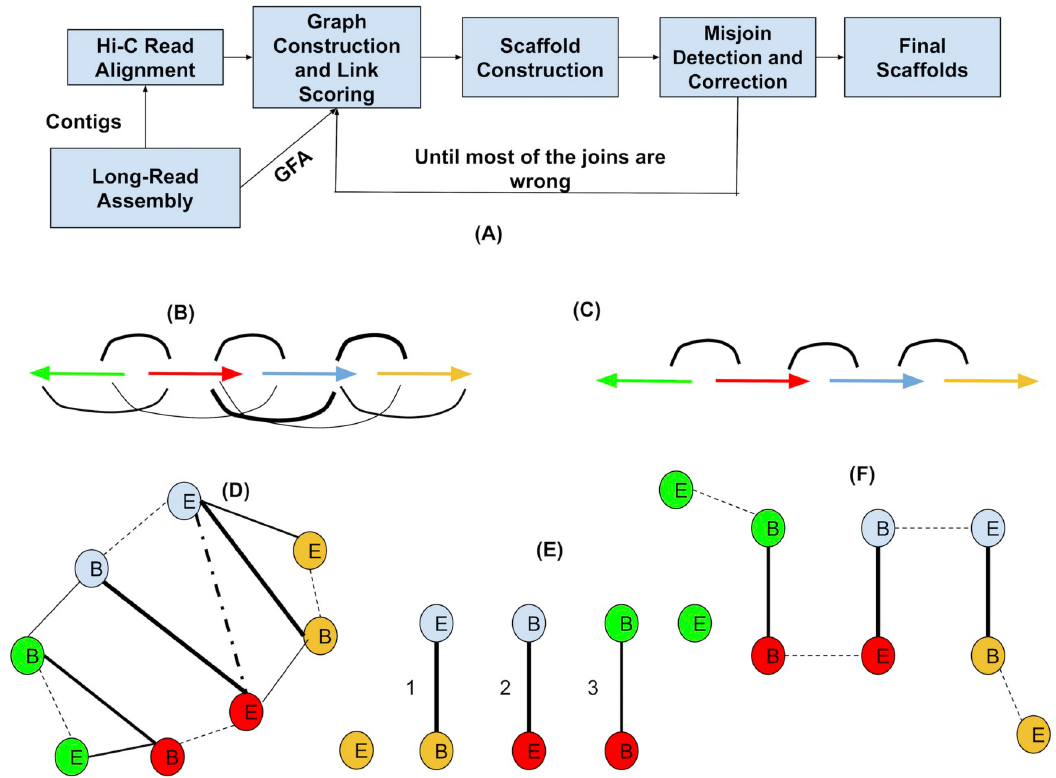
Fig 1. (A) Overview of the SALSA2 scaffolding algorithm. (B) Linkage information obtained from the alignment of Hi-C reads to the assembly. Arrows denote contigs and arcs between arrows denote the inferred linking information from Hi-C reads. Thickness of arcs denote the weight on the Hi-C edge. Thicker edge indicates higher edge weight implied by Hi-C reads (C) Assembly graph obtained from the assembler, where arrows are contigs and arcs denote overlap between contigs(D) Hybrid scaffold graph constructed from the links obtained from the Hi-C read alignments and the overlap graph. Solid edges indicate the linkages between different contigs and dotted edges indicate the links between the ends of the same contig. B and E denote the start and end of contigs, respectively. The E-E edge between blue and red contigs is dashed as this particular orientation between them is not supported by assembly graph, but rather B-E edge is supported. We ignore this dotted edge while computing maximal matching (E) Maximal weighted matching obtained from the graph using a greedy weighted maximum matching algorithm. The numbering of the edges indicates the order in which they were added to the graph. No more solid edges can be added to the matching as it would assign more than one edge to already matched nodes. (F) Edges between the ends of same contigs are added back to the matching to obtain final